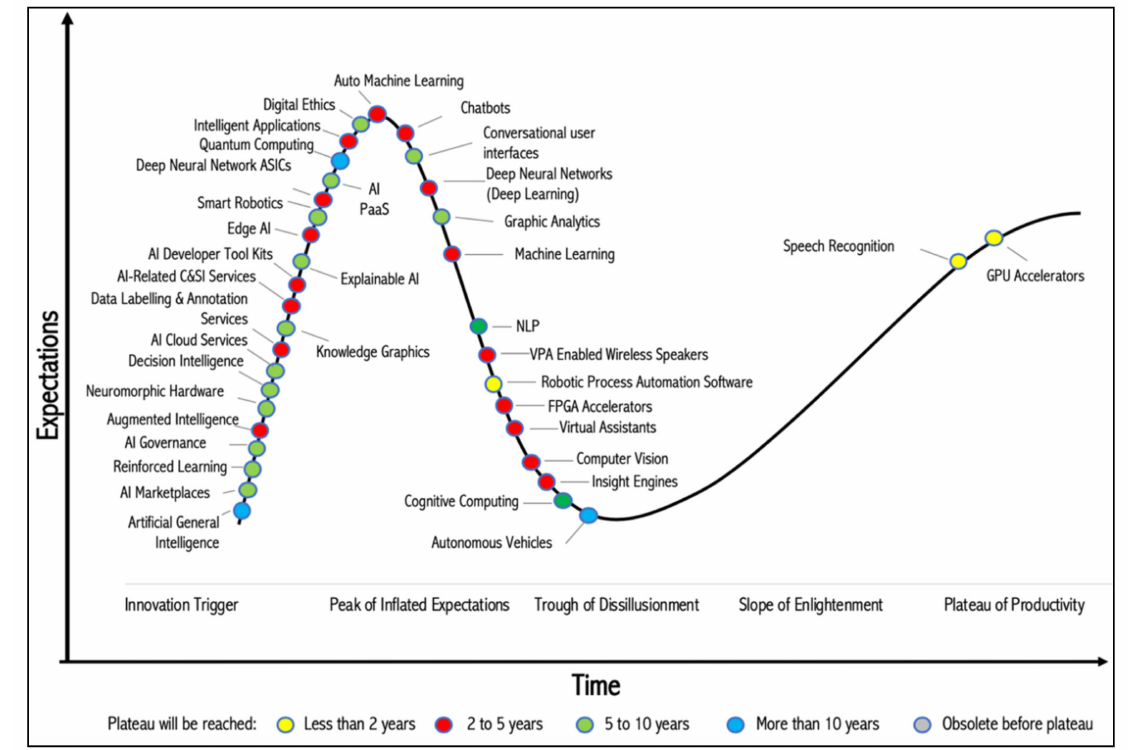
Figure 2. Hype cycle of AI applications, derived from Gartner